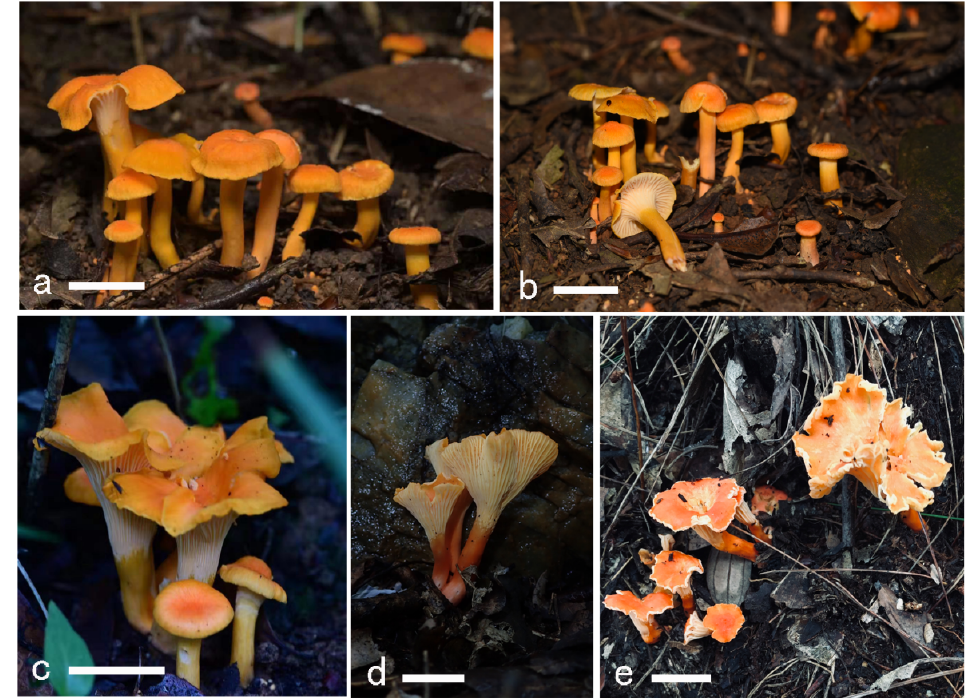
Figure 6. Basidiomata of Cantharellus albovenosus . ( a , b ) GDGM85852. ( c , d ) GDGM85846. ( e ) GDGM85142. Bars = 2 cm.